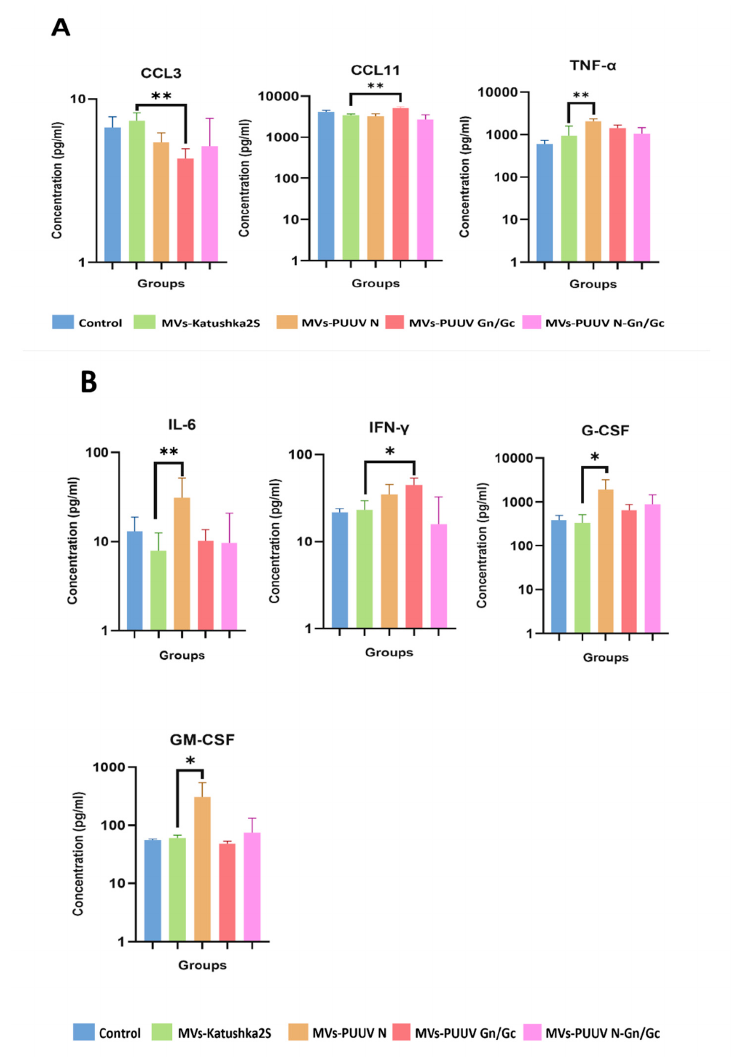
Figure 10. Serum cytokine analysis in mice treated with MVs at 14 and 28 days. Serum level of cytokines and chemokines was determined by using Multiplex method (BioRad). Serum was collected from mice treated with MVs containing PUUV N and Gn/Gc proteins, as well as their combination. Serum from mice treated with 0.9% NaCl solution as well as from mice treated with MVs-Katushka2S served as control. ( A )—Serum cytokines and chemokines levels 14 days after MVs treatment; ( B )—Serum cytokines and chemokines levels 28 days after MVs treatment. Data is represented as median ± SD. * p < 0.05, ** p < 0.01. p value < 0.05 was considered statistically signif- icant.